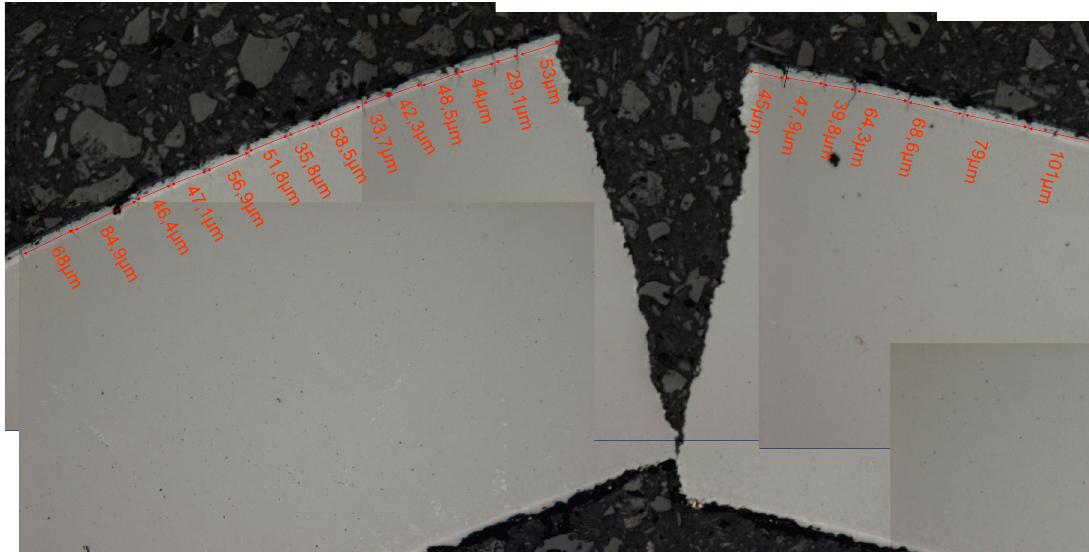
Fig. 4. Crack nucleation and crack spacing at outer diameter equatorial location of CCT1 after